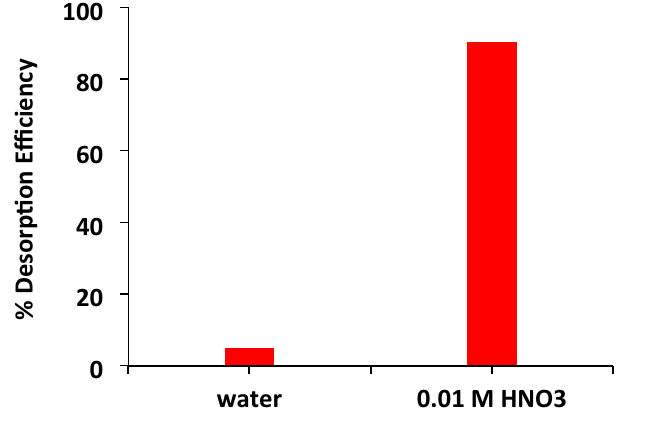
Figure 12. Desorption experiment for cadmium